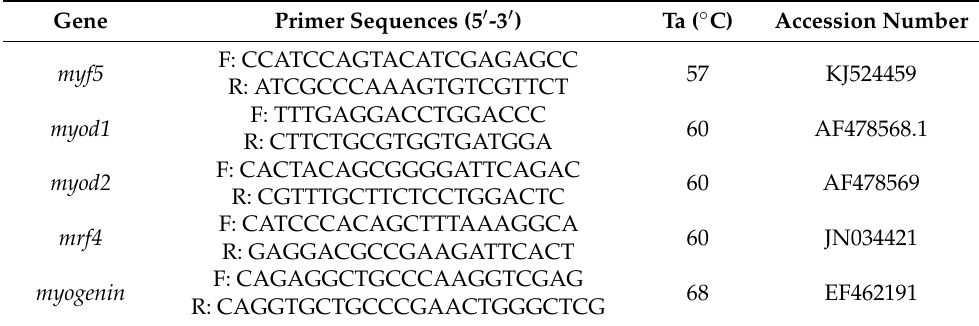
Table 1. Primers used in the Real-Time quantitative PCR